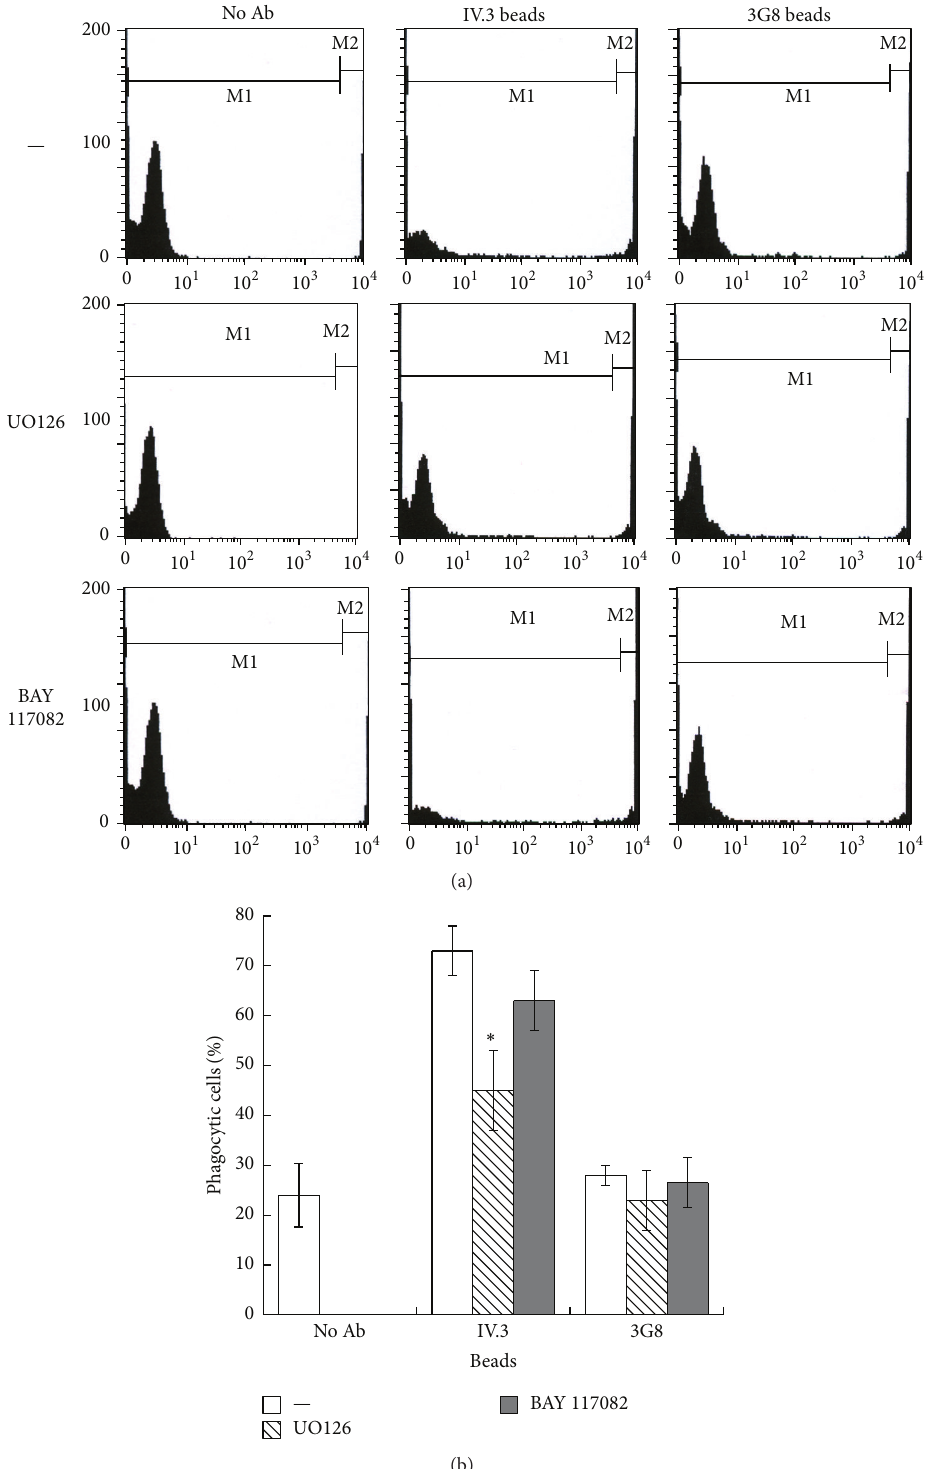
Figure 10: Fc 𝛾 RIIa induces efficient phagocytosis . (a) Human neutrophils were mixed with fluorescence latex particles. Particles were nonopsonized (no Ab) or opsonized with monoclonal antibody (mAb) IV.3 anti-Fc 𝛾 RIIa or with mAb 3G8 anti-Fc 𝛾 RIIIb. Cells were allowed to ingest the particles for 30 min. Phagocytosis of latex beads was also evaluated in the absence (None) or the presence of 50 𝜇 M UO126 (MEK inhibitor) or 2.5 𝜇 M BAY 117082 (NF- 𝜅 B inhibitor). Phagocytosis was assessed by flow cytometry, detecting the reduced number of cells with low fluorescence (M1 marker), and the appearance of cells with high fluorescence in the far right side (M2 marker) of the histogram of gated PMN. (b) Phagocytosis was quantified by flow cytometry, as the percentage of high-fluorescence cells (marker M2) in the histogram of gated PMN. Data are representative of four separate